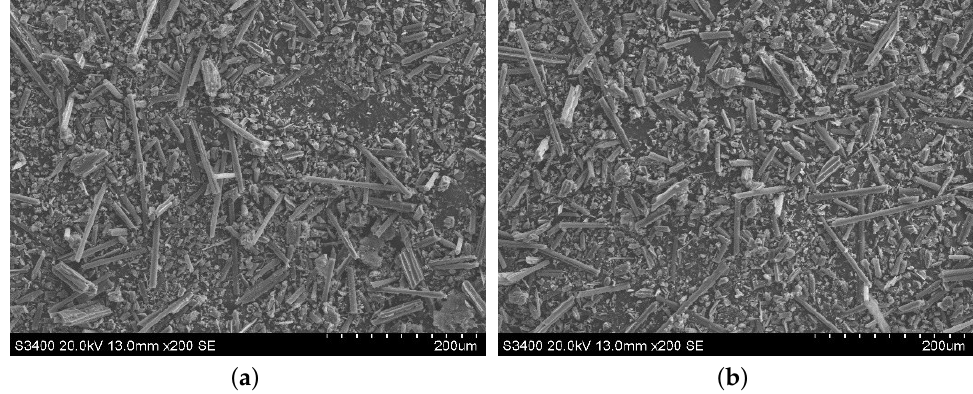
Figure 17. Morphologies comparison when a p is 0.1 mm. ( a ) is ordinary cutting and ( b ) is ultrasound- assisted cutting.